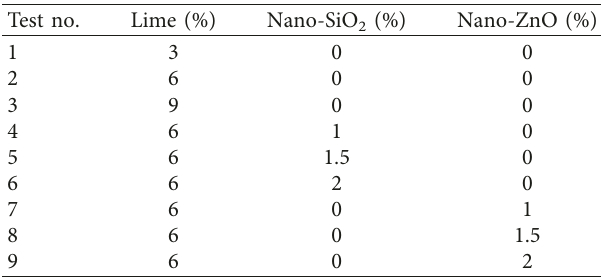
Table 6: Mixture proportions of used materials. Test